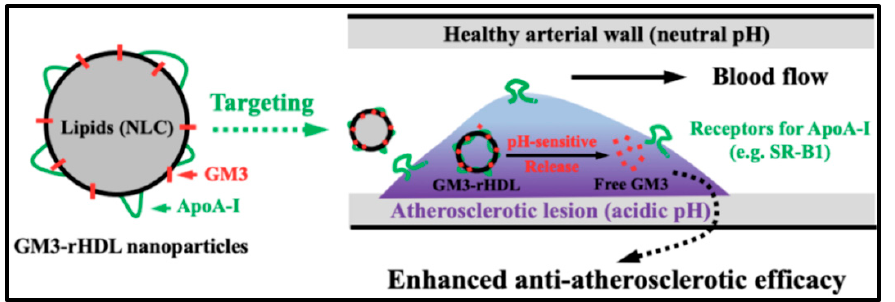
Figure 10. Schematic diagram showing the lesion targeting of GM3-rHDL nanoparticles and pH- responsive release of free GM3 under an acidic condition in atherosclerotic plaques.